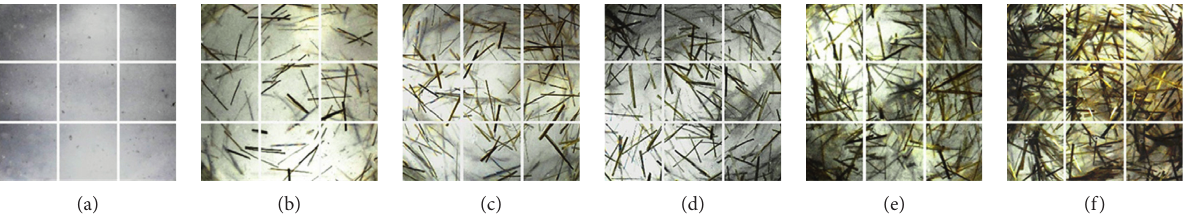
Figure 2: Fiber-transparent soil model with different content. (a) 0kg/m 3 . (b) 1.5kg/m 3 . (c) 3kg/m 3 . (d) 4.5kg/m 3 . (e) 6kg/m 3 . (f) 7.5kg/m 3 .